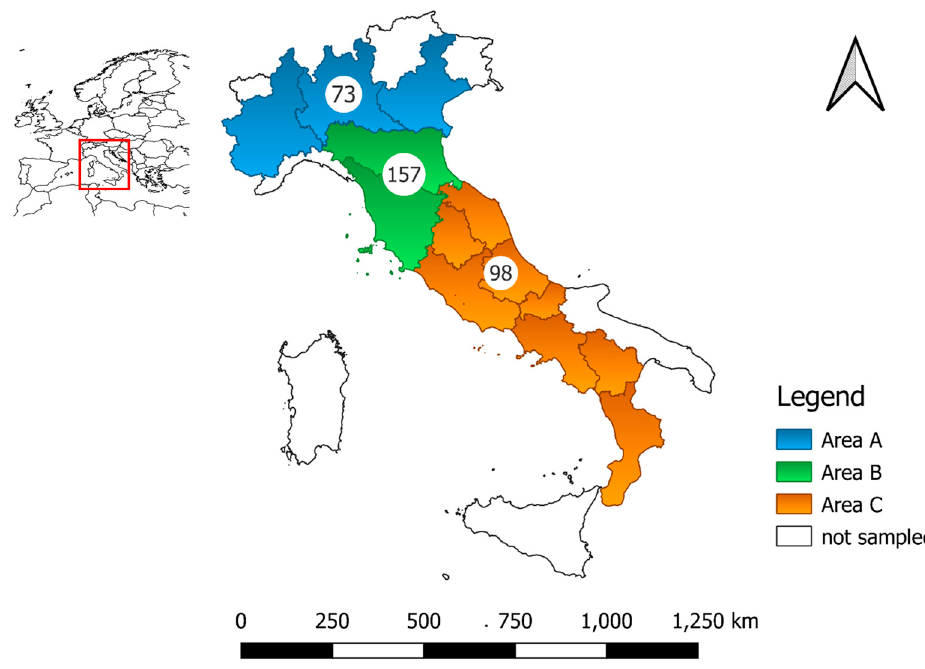
Figure 1. Map of Italy indicating the three areas of sampling and number of livers sampled.